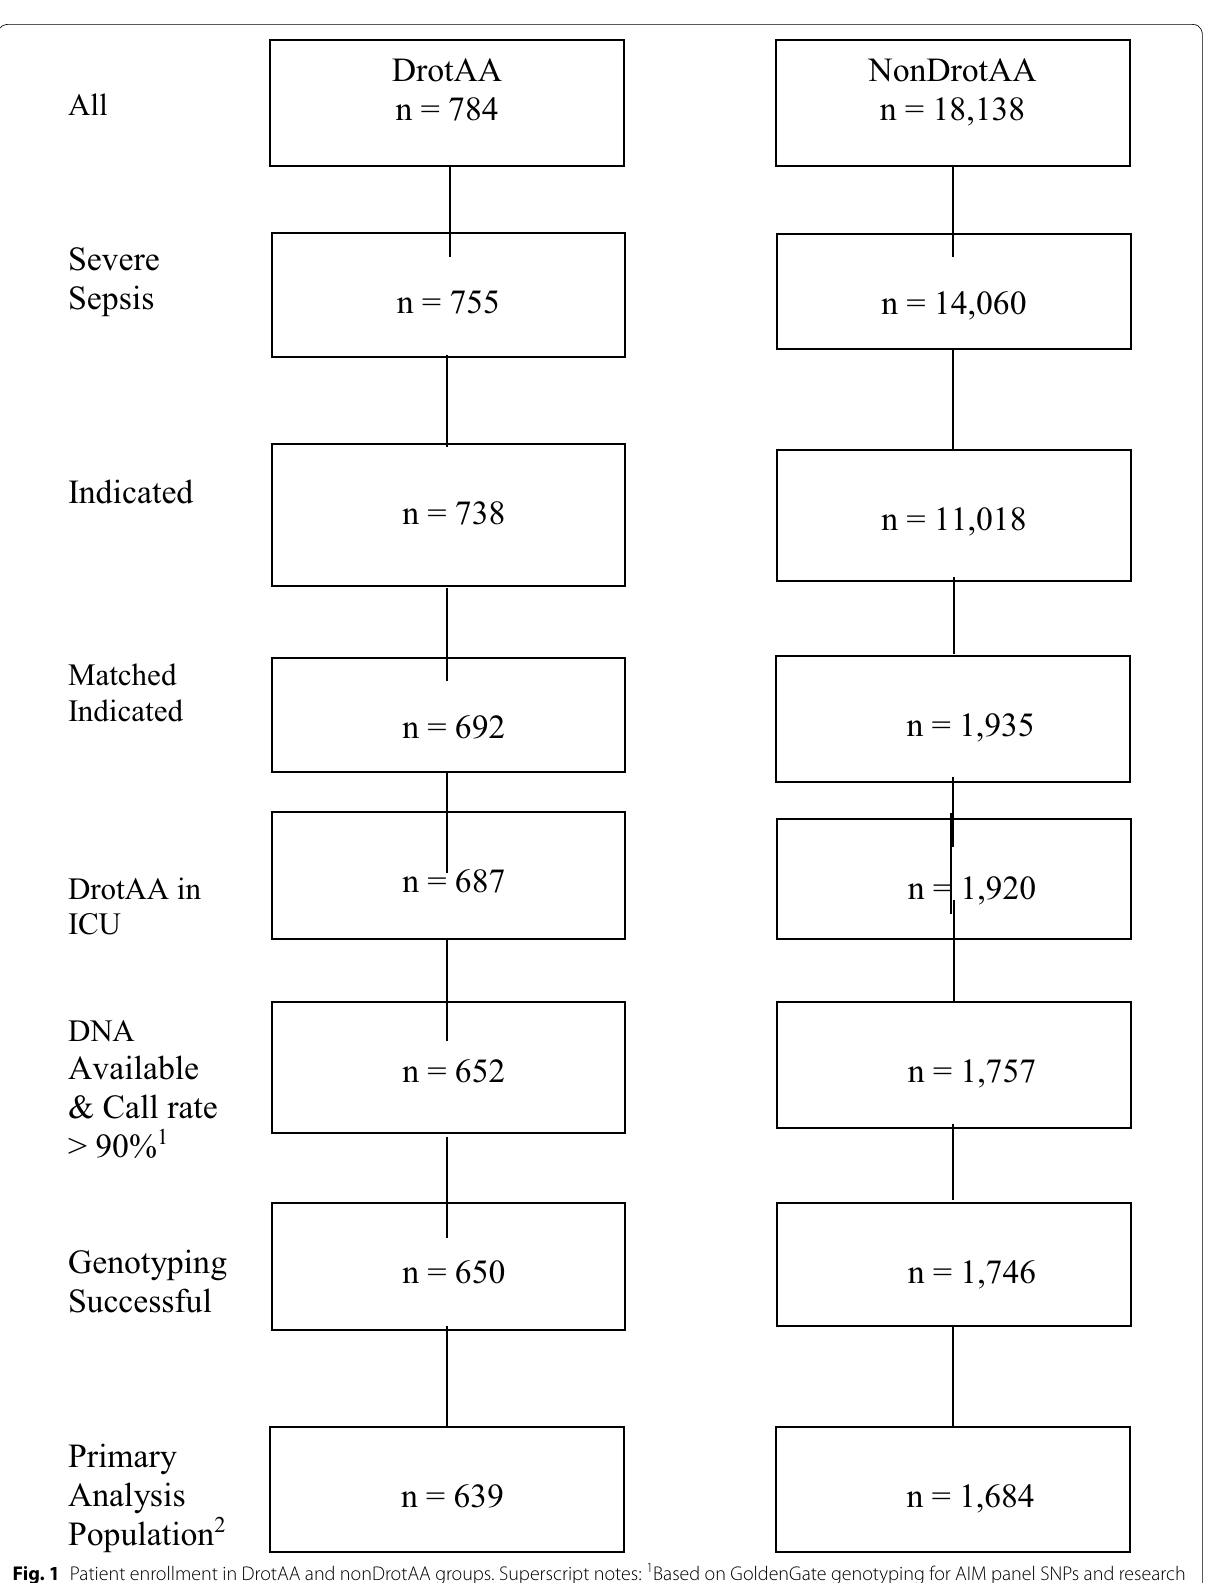
Fig. 1 Patient enrollment in DrotAA and nonDrotAA groups. Superscript notes: 1 Based on GoldenGate genotyping for AIM panel SNPs and research SNPs. 2 Each matched set required 1 DrotAA‑treated patient and 1–3 nonDrotAA‑treated